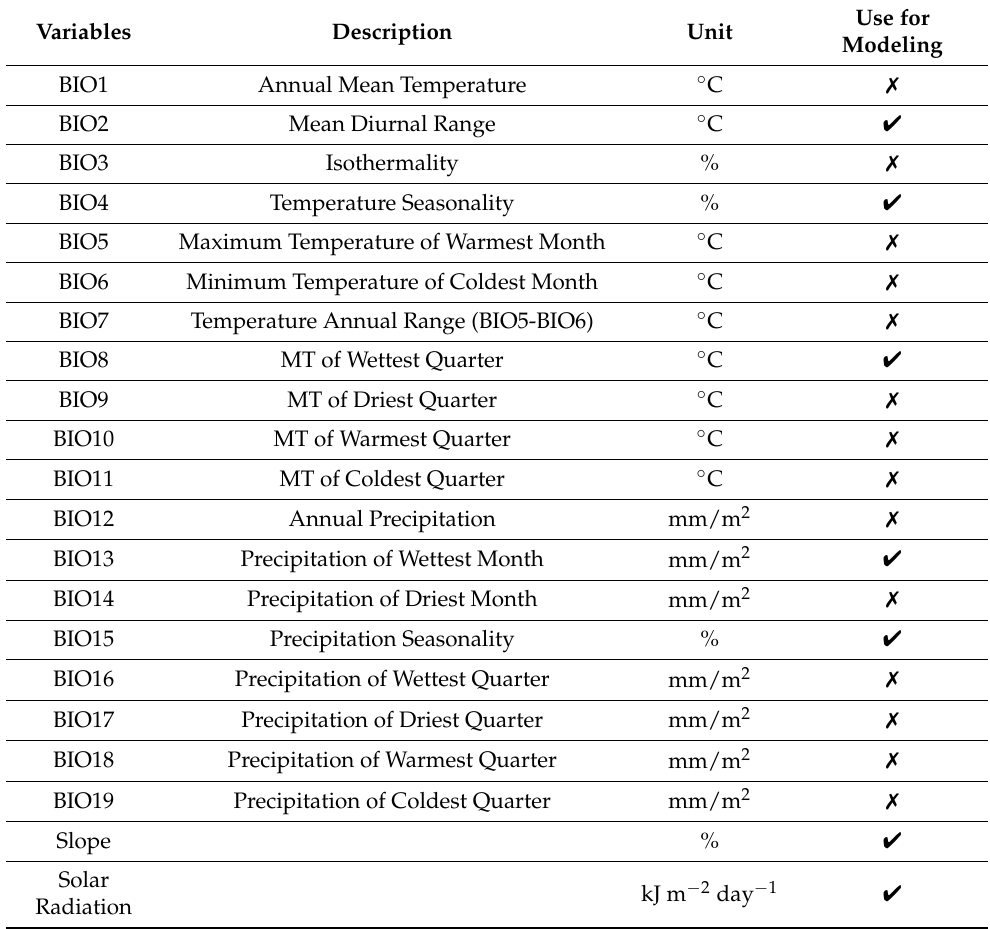
Table 1. Environmental attributes including mean temperature (MT), maximum temperature, mini- mum temperature and precipitation considered for modeling the distribution of Quercus brantii .